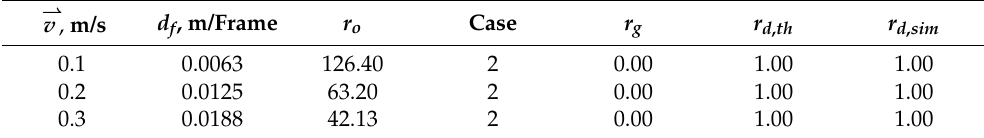
Table 6. Theoretical and simulation performance of the CNN-based vision module for plant detec- tion at 𝑆 = 0.79 m , 16 𝑓𝑝𝑠 , and at three-levels of travel velocity ( 𝑣⃑ ). 𝒗(cid:4652)(cid:4652)⃑ , m/s